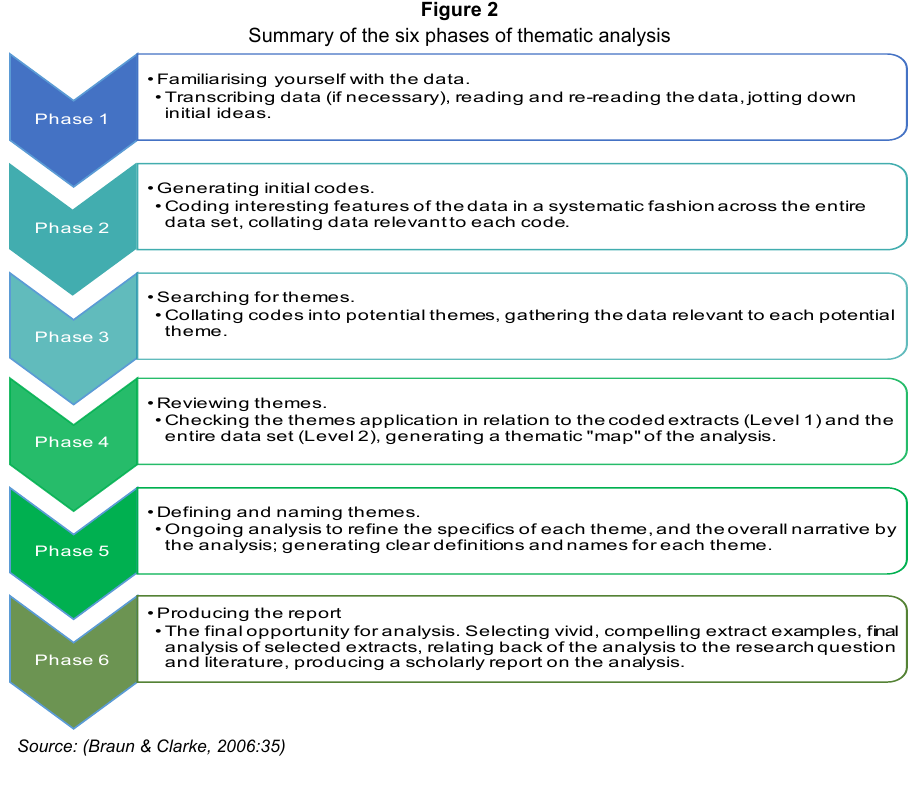
Figure 2 Summary of the six phases of thematic